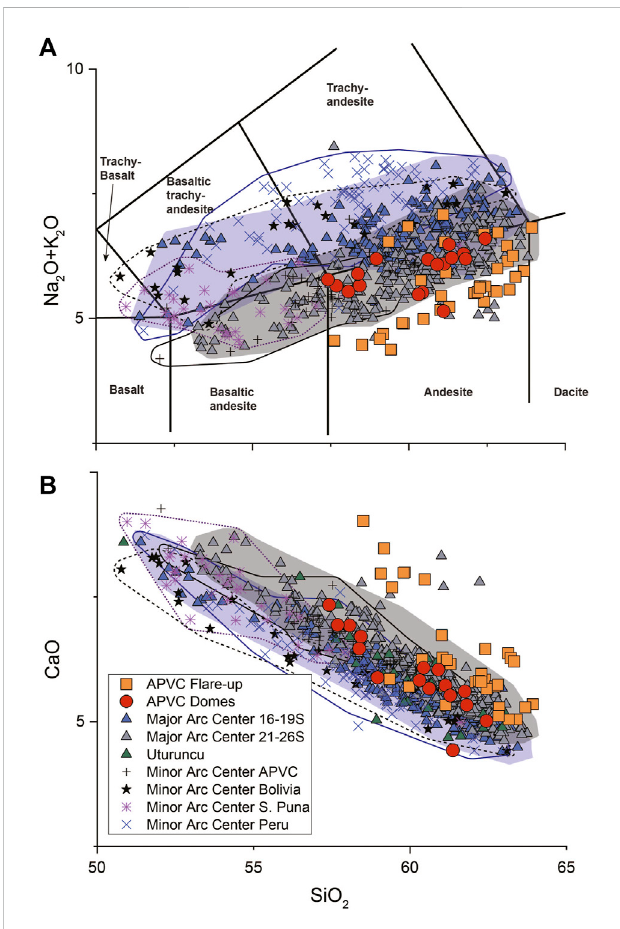
FIGURE 2 (A) Plot of SiO 2 vs. total alkali concentrations and (B) SiO2 vs. CaO concentrations. Panel A includes TAS classi fi cation grid following Le Maitre (1989). All plotted data has been fi ltered to only include SiO 2 concentrations between 50 and 63 wt.% SiO 2 . Description of symbols and units for all panels are included in panel (B) . Individual groups are outlined to aid in